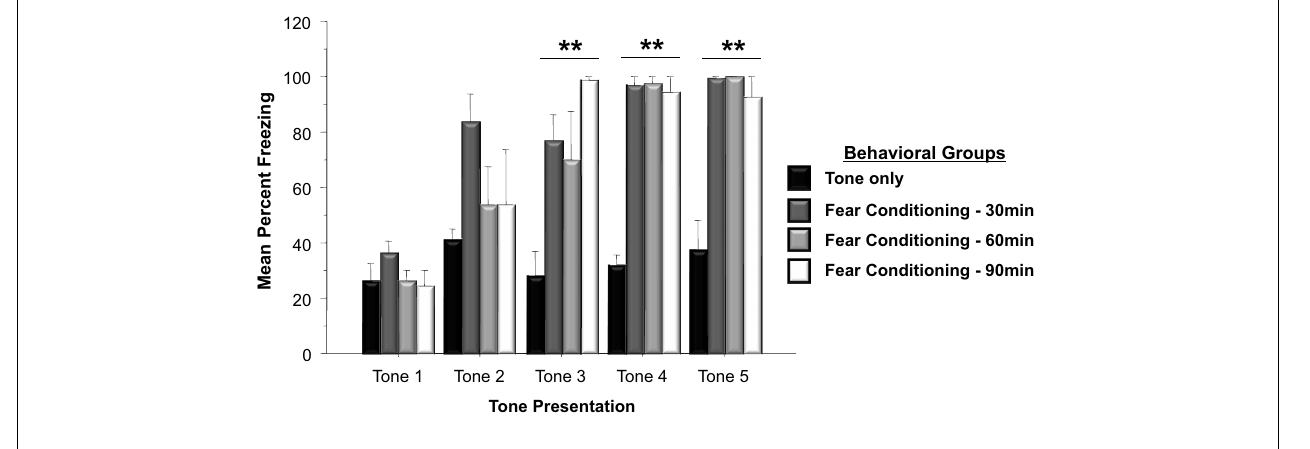
FIGURE 2 | Mean ( + SE) percentage of time freezing during Pavlovian conditioning with a 30s tone CS that coterminated with a 1s 35mA footshock. Subjects in the Fear Conditioning group displayed significantly more freezing during the final three